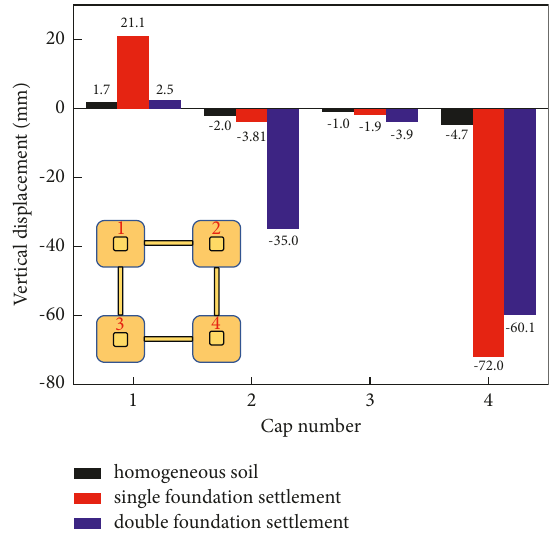
Figure 12: Vertical displacement contrast diagram of